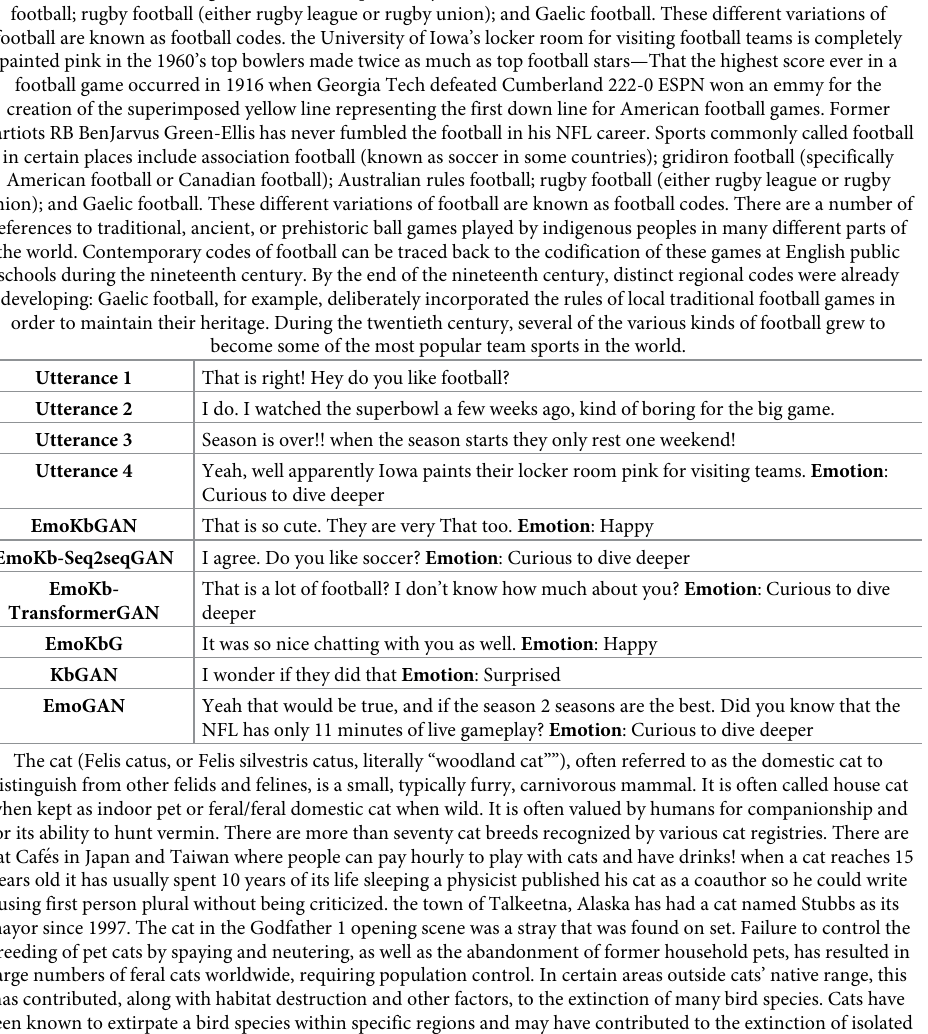
island populations. Results of a genetic study in 2007 showed that all domestic cats descended from the Near Eastern wildcat and diverged around 8000 BC in the Middle East. A 2017 study confirmed that domestic cats